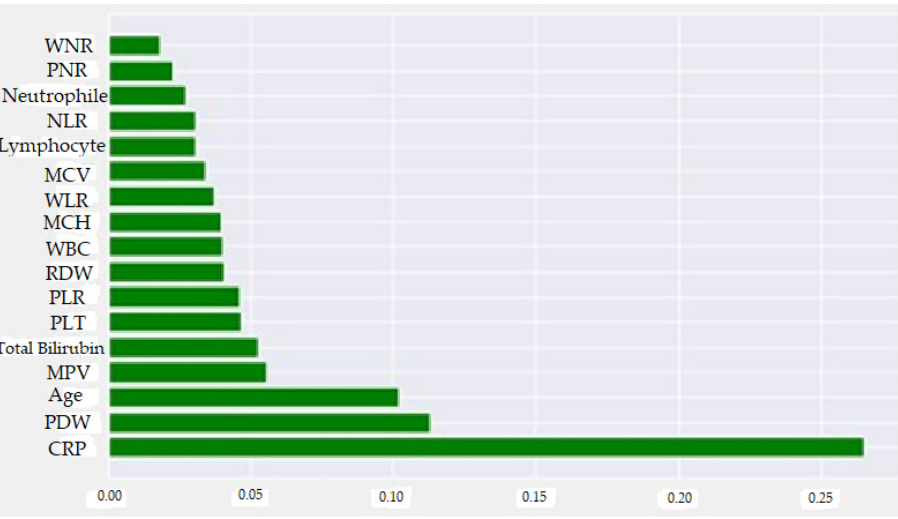
Figure 5. Graphical representation of the findings for the SHAP method for perforated AAp. Table 4. Importance values of factors for classification of perforated AAp.